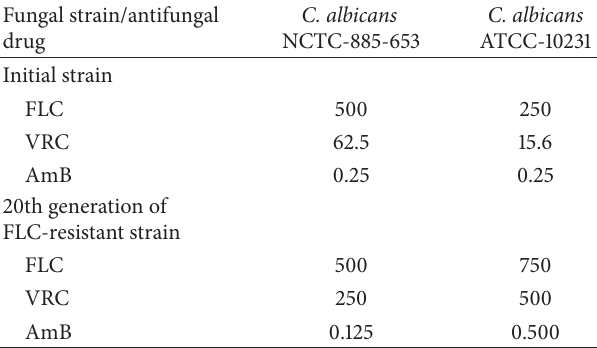
Table 3: MIC ∗ values ( 𝜇 g/mL) for antifungal drugs FLC, VRC,